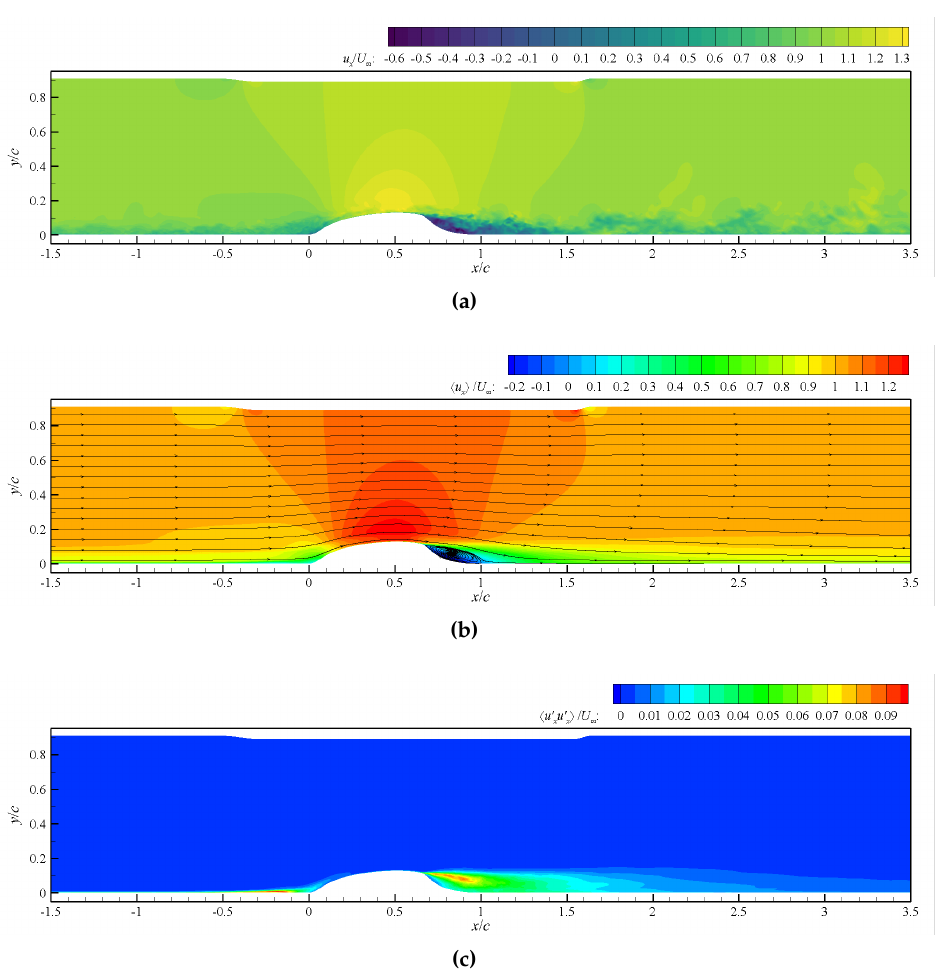
Figure 9. ( a ) Instantaneous streamwise velocity, ( b ) mean streamwise velocity and ( c ) mean resolved streamwise Reynolds stress in the vertical